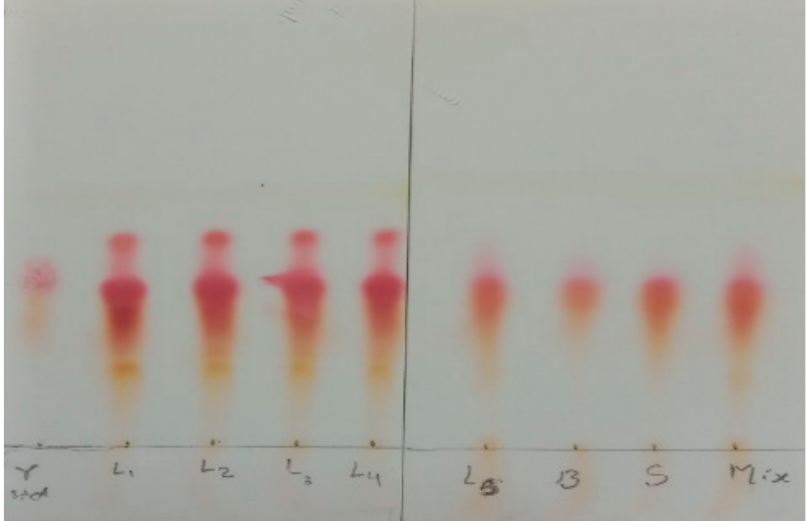
Figure 2. Chromatogram of screening GABA production by TLC method. The development solvent consists of n-butanol: acetic acid: water (5:3:2, v / v ). The chromatogram was observed after spraying the plates with a 2% ninhydrin solution and developing at 105 °C for 5 min. ( γ std: standard gamma aminobutyric acid, L 1 : L. reuteri KUKPS6103, L 2 : L. rhamnosus KUKPS6007, L 3 : L. paracasei KUKPS6201, L 4 : L. acidophilus KUKPS6107, L 5 : L. salivarius KUKPS6202, B: B. coagulans KPSTF02, S: